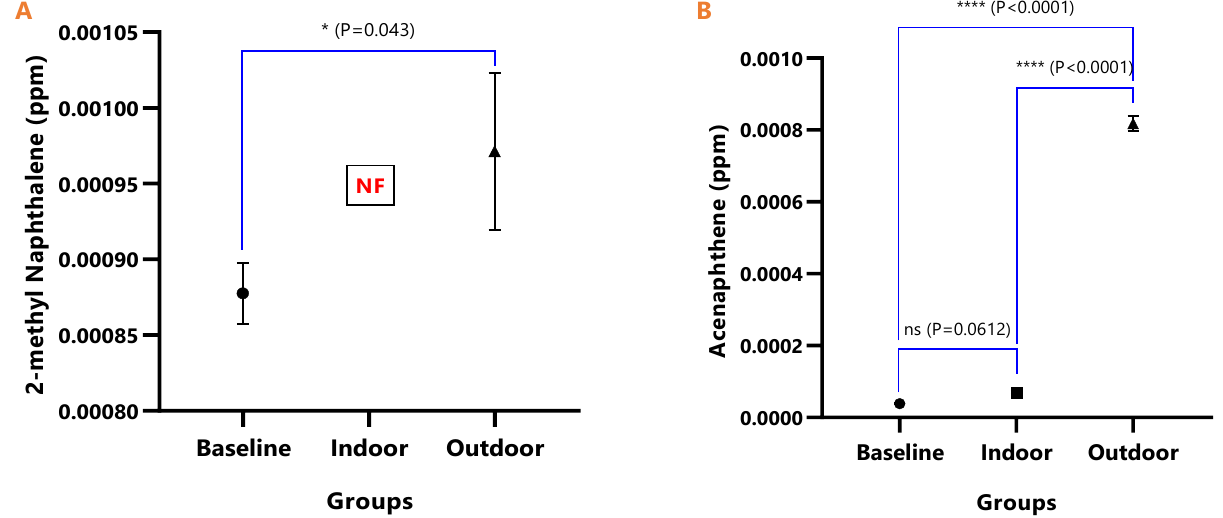
Figure 4. The mean concentrations and test of mean difference for ( A ) 2-methyl Naphthalene and ( B ) Acenaphthene in the various animal groups.